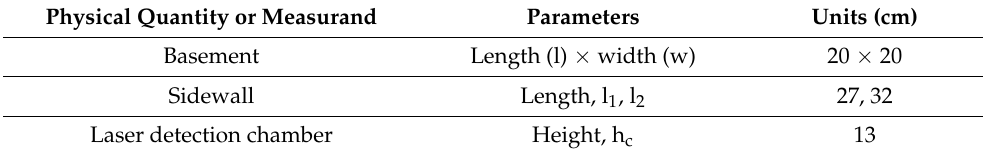
Table 2. Design parameters of the dispensing device.